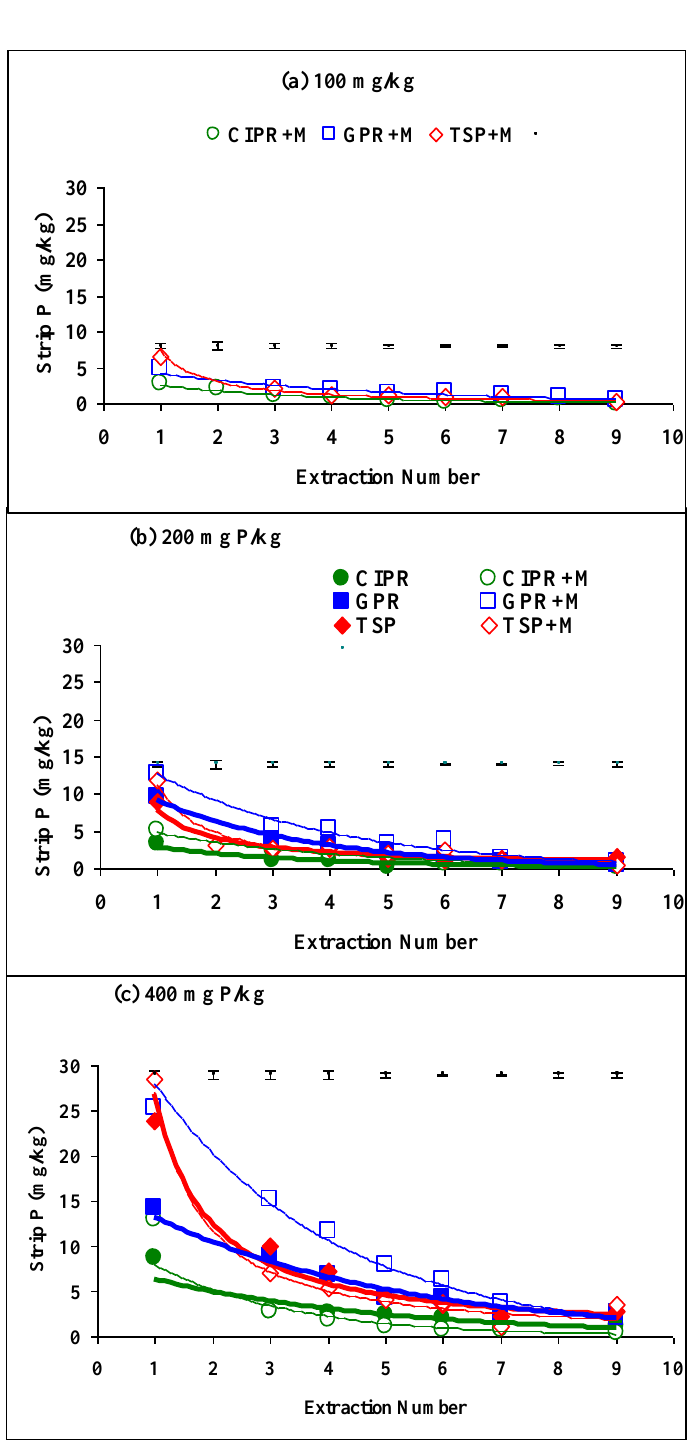
FIGURE 2 . Effects of P source  manure  strip number on strip P at fertilizer rate (a) 100 mg P kg -1 , (b) 200 mg P kg -1 , and (c) 400 mg P kg -1 . Note: sole P sources were not presented in